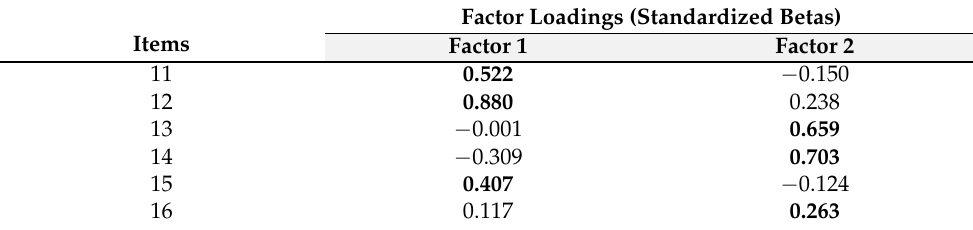
Table 5. Exploratory factor analysis of the self-care management scale.